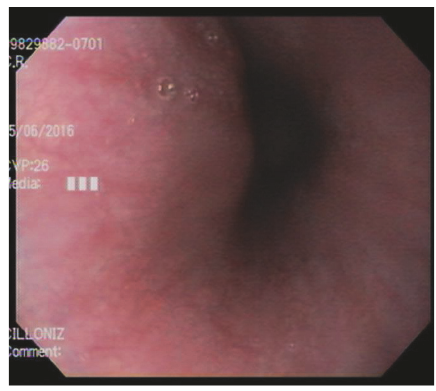
Figure 5: Erythema and desquamation of